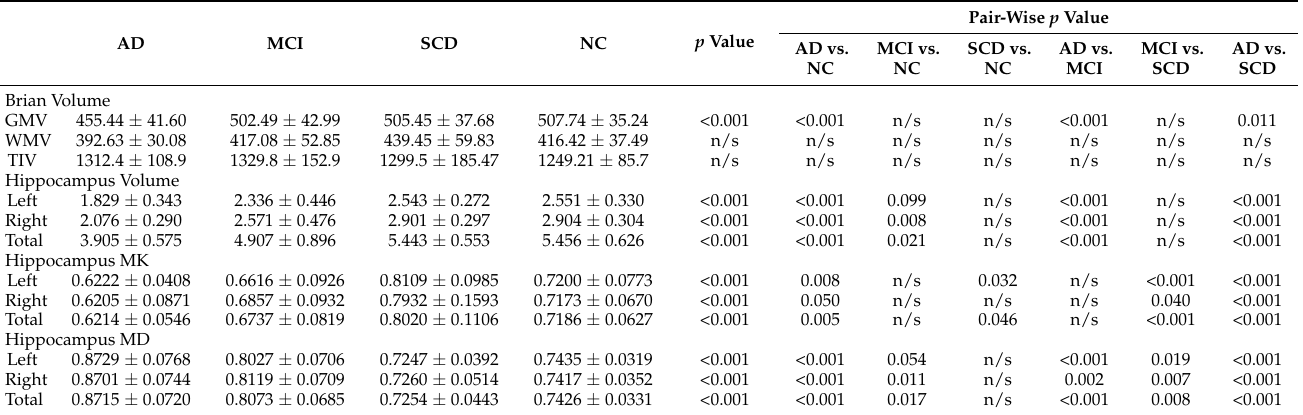
Table 2. Brain volume, hippocampal volume, MD and MK of AD spectrum and NC.